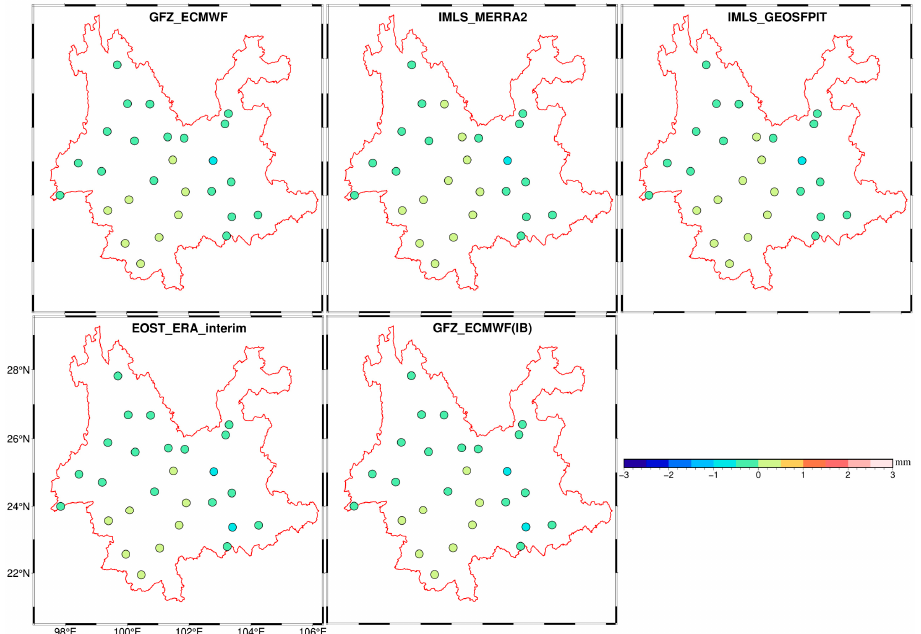
Figure 6. The correlation between five ATML products and vertical GPS time series at 27 GPS stations.